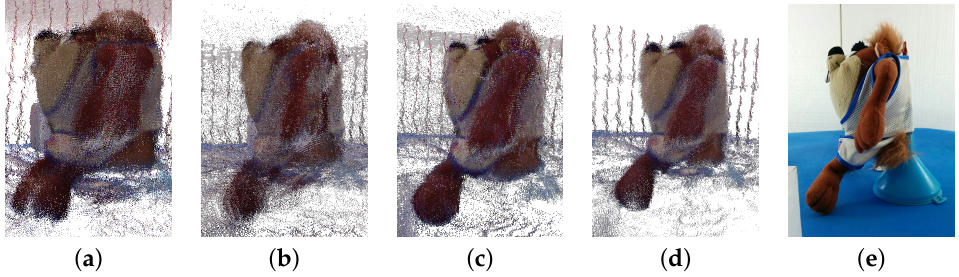
Figure 21. Side view of the reconstruction of the Object 1 obtained using different calibration methods with Microsoft Kinect v1. ( a ) Original; ( b ) Burrus; ( c ) Bouguet; ( d ) Herrera; ( e ) Real.